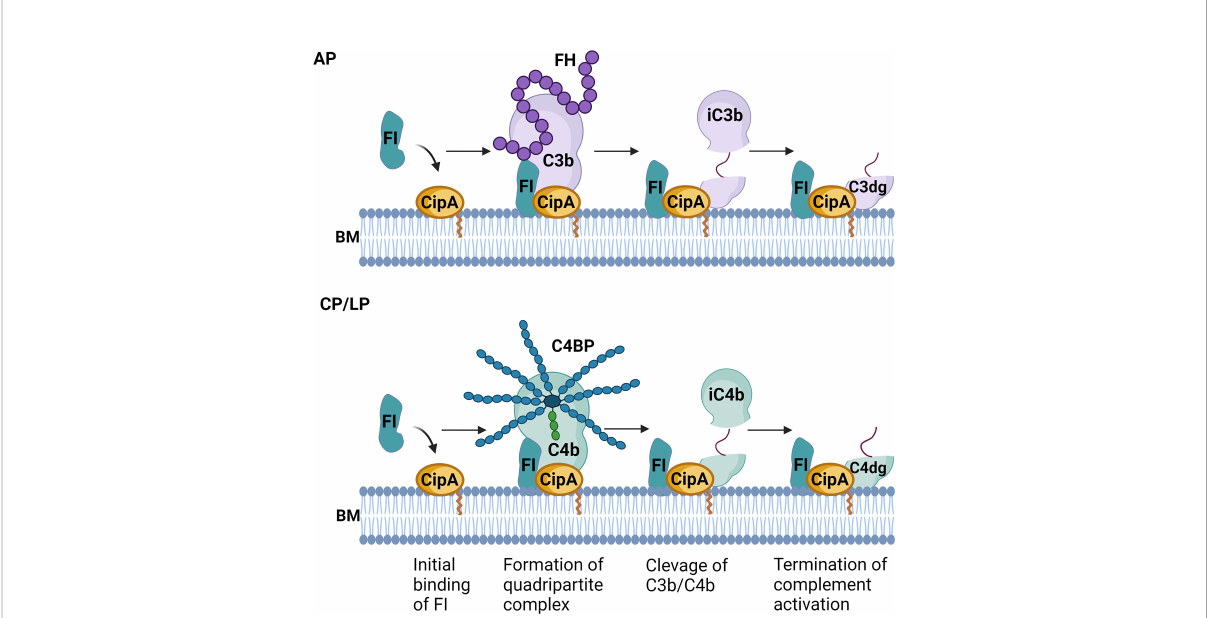
FIGURE 8 Molecular mechanism of complement inactivation mediated by CipA (hypothetical). Schematic representation of the molecular mechanism of complement inactivation by generating a quadripartite complex consisting of CipA, FI, C3b, and FH or CipA, FI, C4b, and C4BP to down regulate the AP, CP, and LP. BM, bacterial membrane. The fi gure was created with